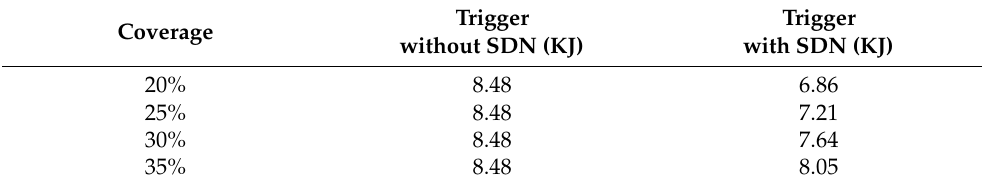
Table 1. Node energy consumption in one day in different deployment modes.